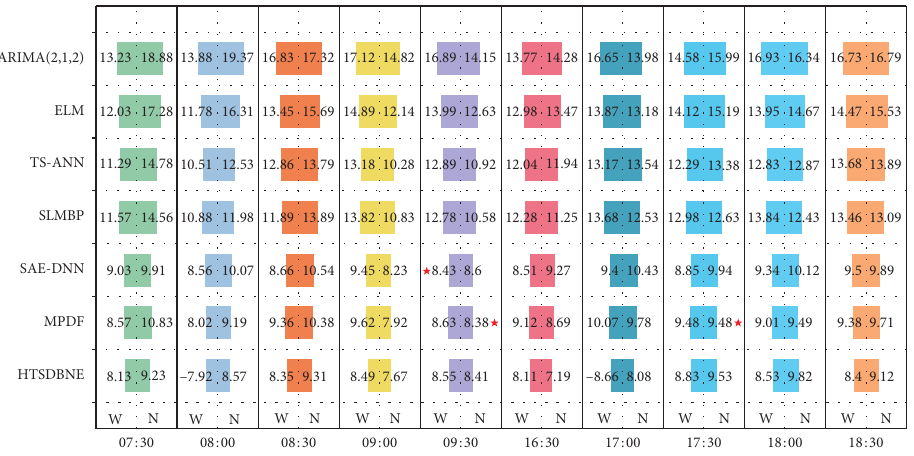
Figure 14: Comparison between HTSDBNE and other models (MSE) (station 8 of line 10). The column W shows the results of working day, and column N shows the results of nonworking